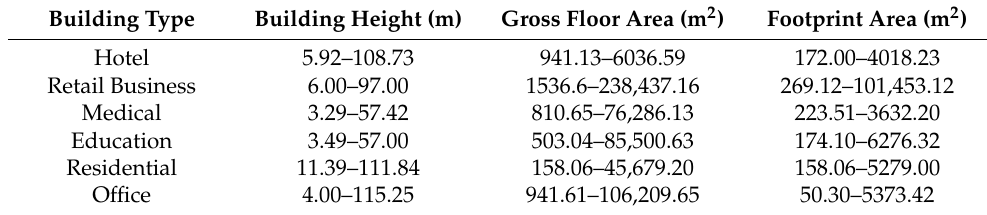
Table 1. Range of physical information for different types of sample